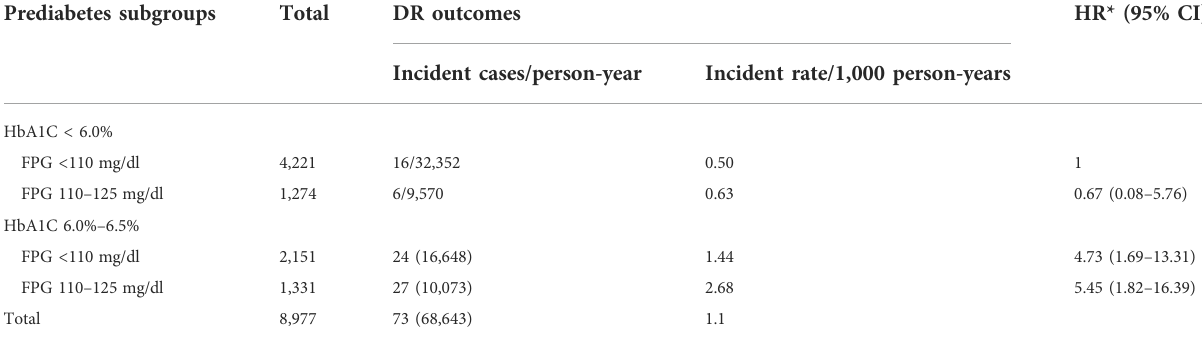
TABLE 3 Incidence and hazard ratios for the development of diabetic retinopathy by baseline prediabetes subgroup. Prediabetes